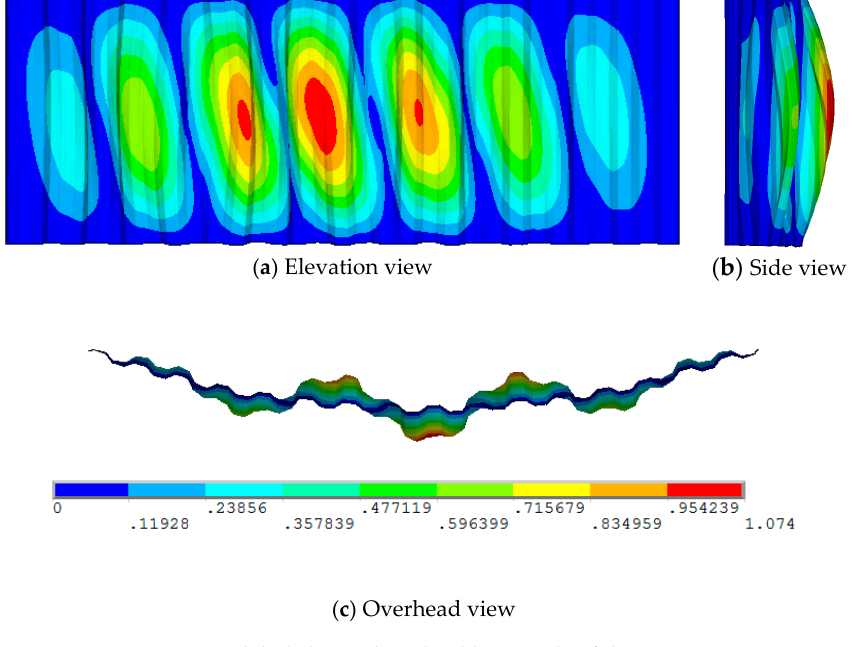
Figure 5. Global elastic shear buckling mode of the PCCSW.